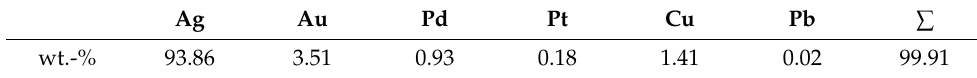
Table 1. Chemical composition of the raw silver